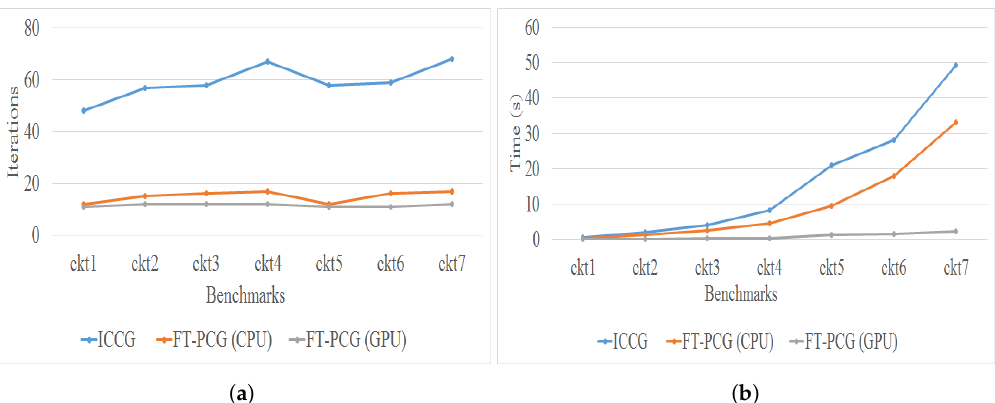
Figure 3. ( a ) Average number of iterations, ( b ) Average runtimes for each time-step in each